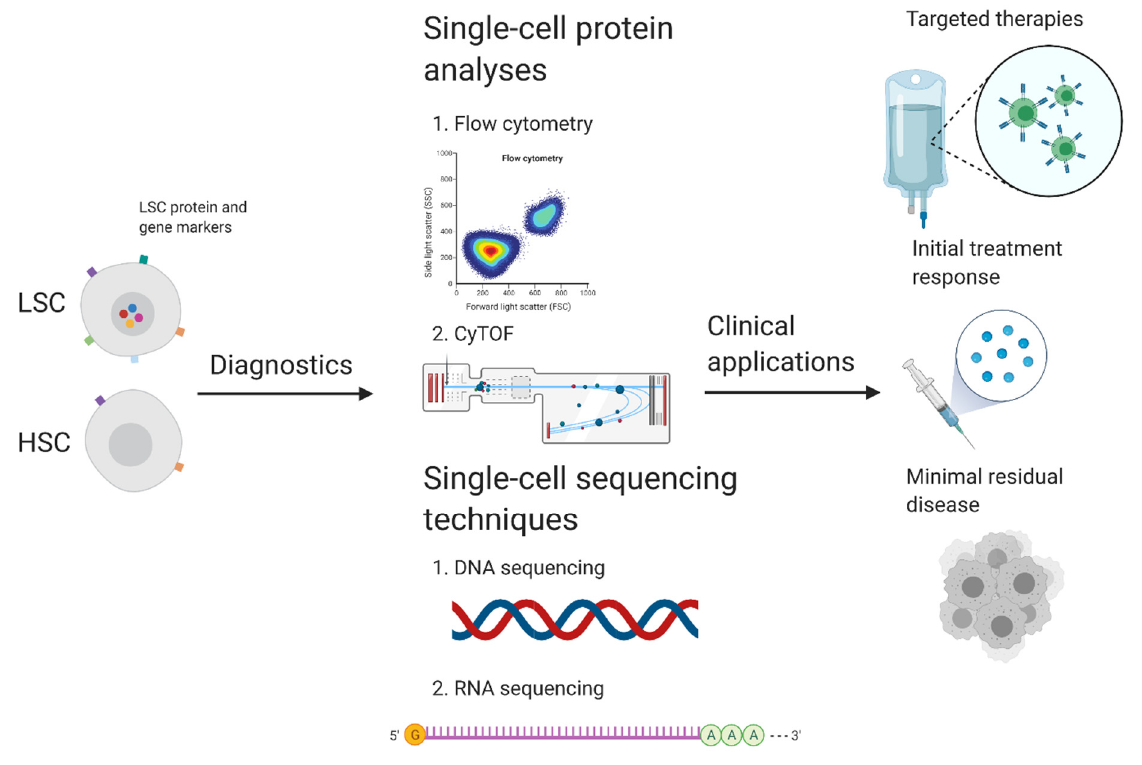
Figure 2. Potential implications of distinguishing normal and leukemic blast cells based on protein and/or gene profiles. Distinguishment of normal and leukemic blast cells based on their protein and/or gene expression profile can be performed by single-cell protein analysis techniques, such as flow cytometry and CyTOF, and/or single-cell sequencing of their DNA or RNA profile. Combining these techniques to detect (therapy specific) protein or gene markers can lead to the development of novel targeted therapy approaches, monitoring of initial treatment response, and detection of min- imal residual disease to prevent relapse.